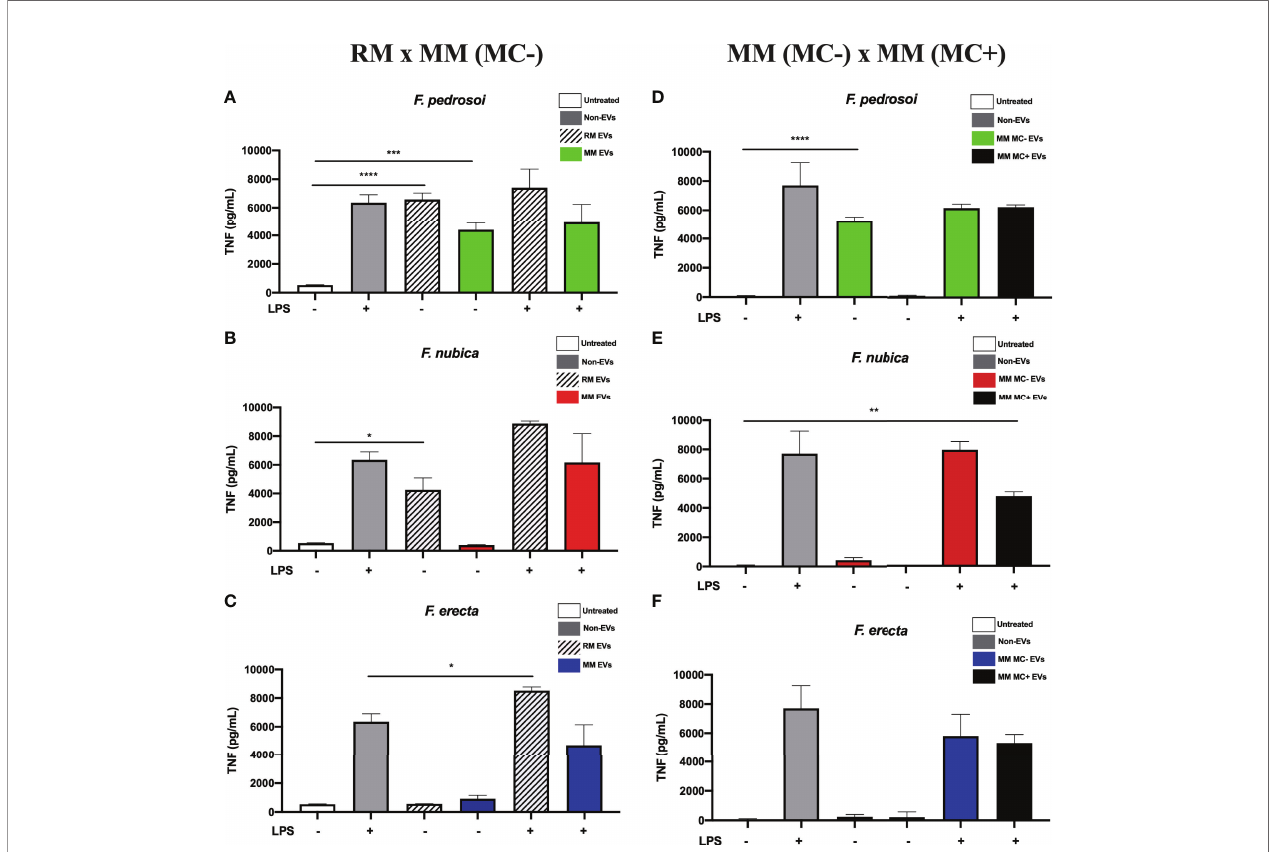
FIGURE 3 | EVs from F. pedrosoi and F. nubica isolated from the rich medium can promote TNF production by bone-marrow-derived macrophages (BMDMs). MM MC- stands for minimum medium without muriform cells and MM MC+ for minimum medium in the presence of muriform cells. EVs (80 ng/mL of sterol content) from F. pedrosoi (A, D) , F. nubica (B, E) , and F. erecta (C, F) grown in RM, MM MC-, and MM MC+ were incubated with 1x10 6 BMDMs in the presence or absence of lipopolysaccharide (LPS, 500 ng/mL) for 24h. Cytokine production was assessed by enzyme-linked immunosorbent assay (ELISA). For all plots, * indicates p < 0.05, ** indicates p < 0.01, *** indicates p < 0.001, **** indicates p < 0.0001 compared to negative and positive controls according to one-way analysis of variance (ANOVA). The results presented in this work refer to a representative triplicate group experiment of at least two independent